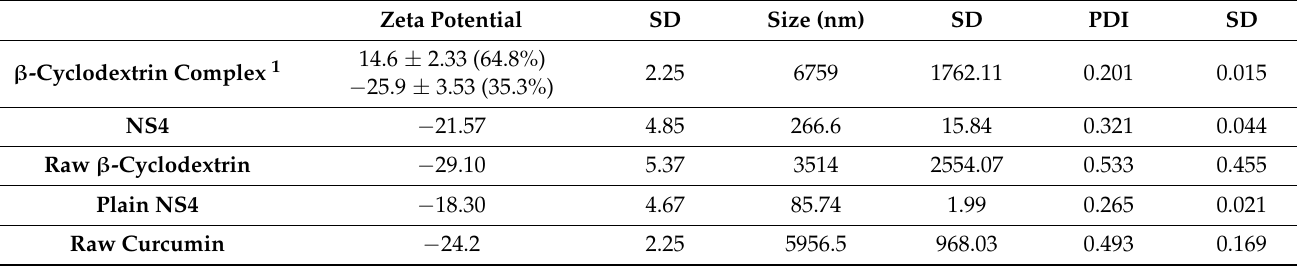
Table 2. Zeta potentials, particle size, and size distribution of the prepared complexes.